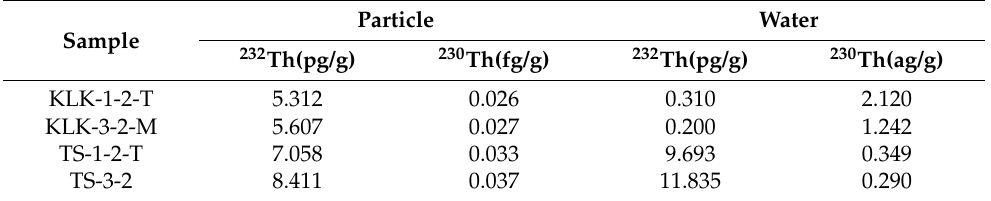
Table 5. The concentration of thorium in suspended particles and water in Keluke Lake and Tuosu Lake.